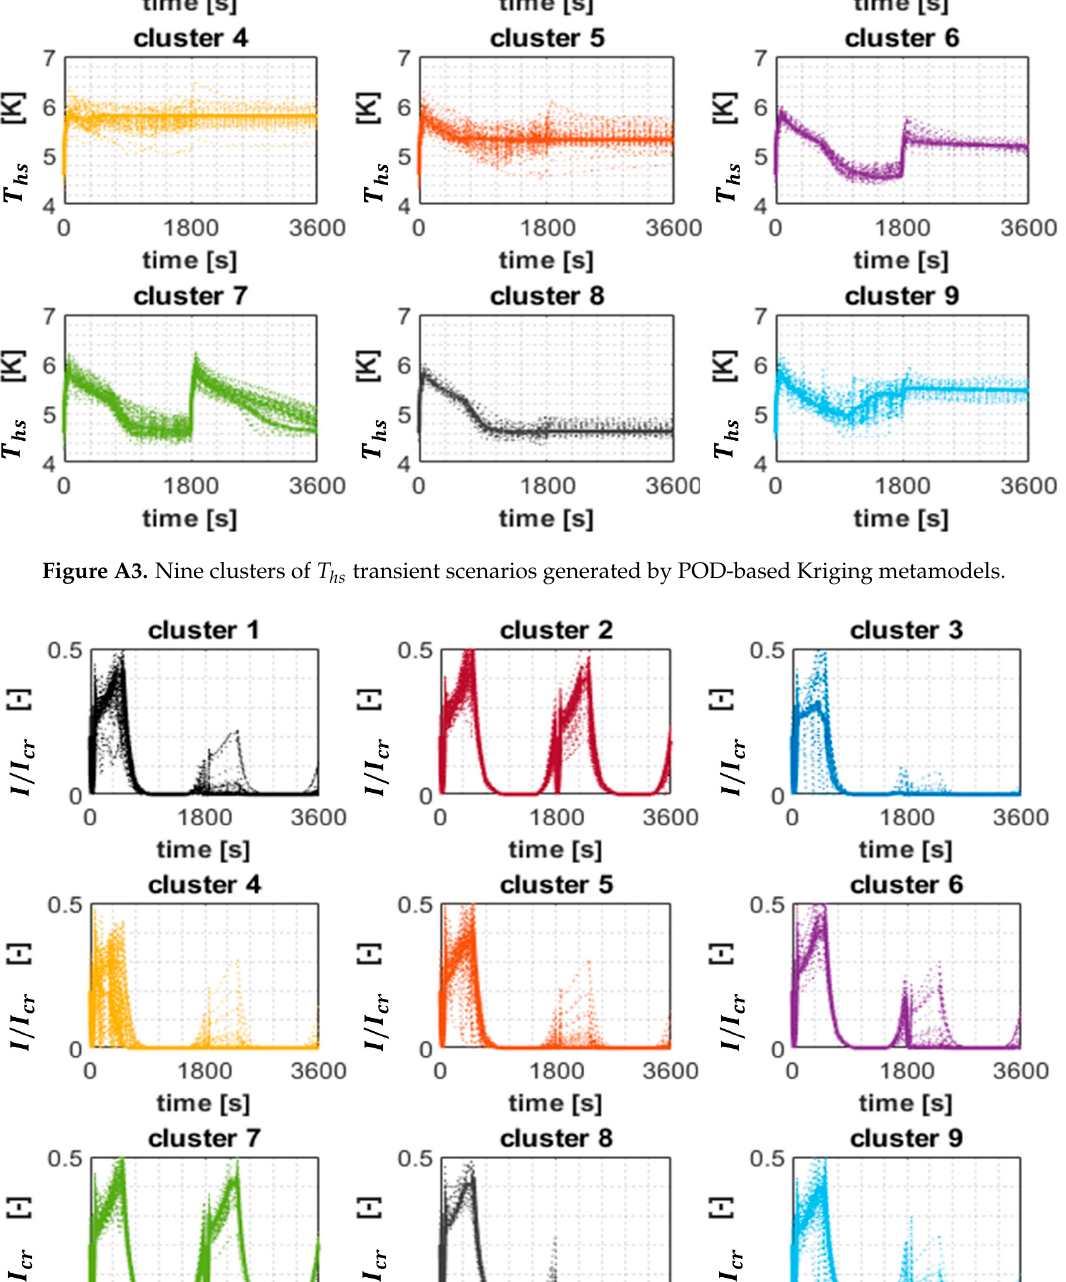
Figure A4. Nine clusters of (cid:1835)/(cid:1835) (cid:3030)(cid:3045) transient scenarios generated by POD-based Kriging metamodels.